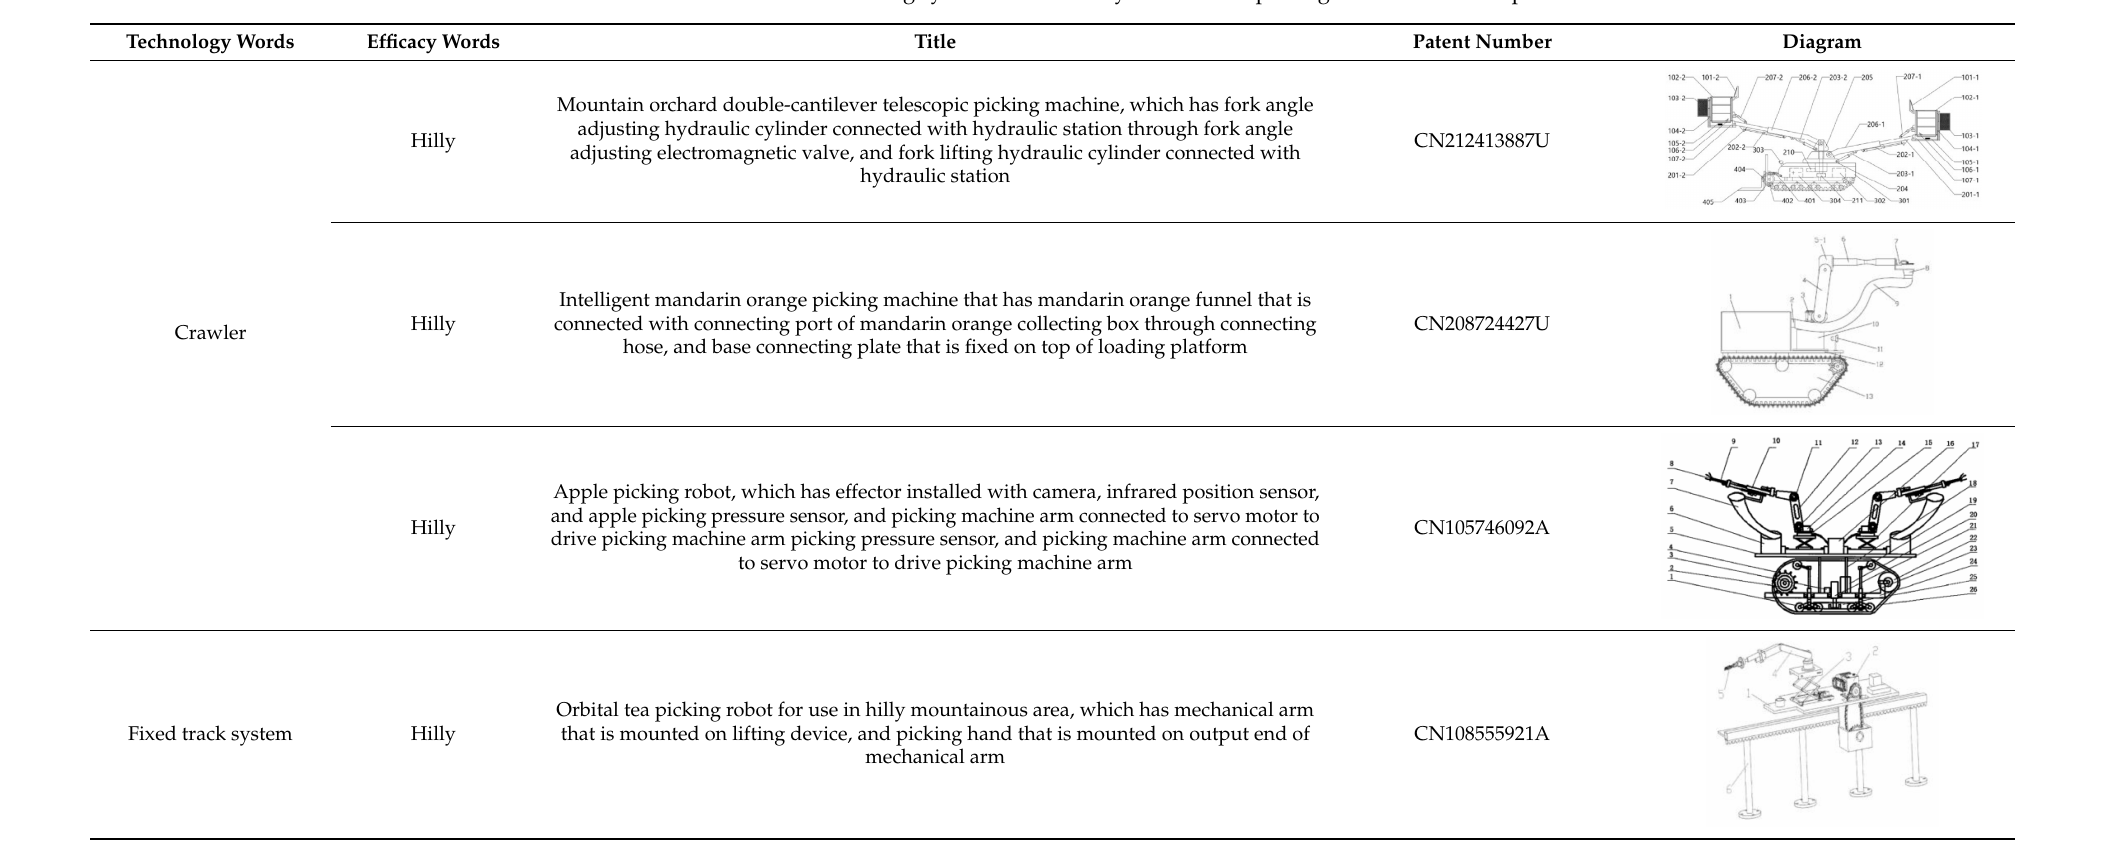
Table 5. Technical scheme of the moving system and the body of the citrus picking robot and related patents.